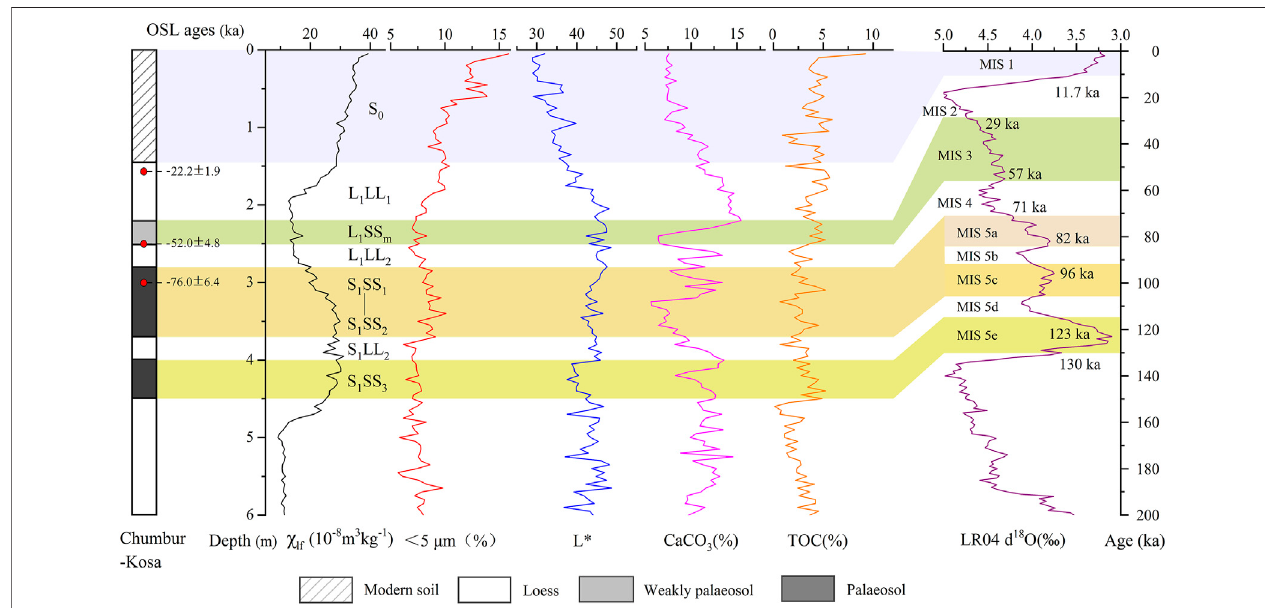
FIGURE7| Re fi nedchronostratigraphyoftheChumbur-Kosasectionwithluminescenceagesandmultipleclimateproxies(the χ lf , < 5 μ m,L*,CaCO 3 %,andTOC), and its correlation with benthic LR04 stack records from Lisiecki and Raymo (2005). The quartz OSL ages are derived from Chen et al. (2018b).